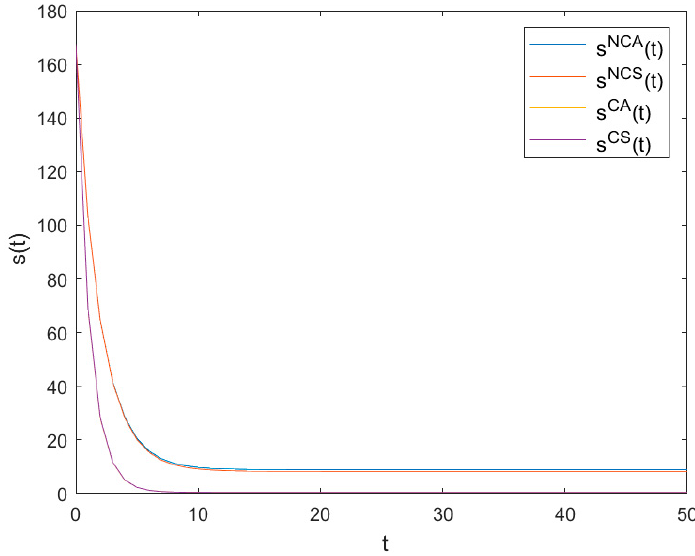
Figure 1. Evolutions of optimal trajectories of the pollutant stock levels.